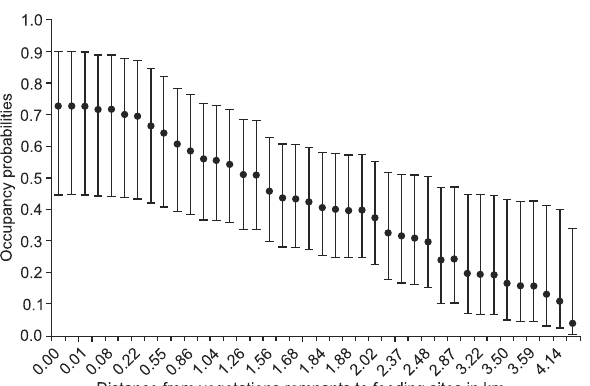
Figure 3. Estimate of occupancy probability of vegetation rem- nants as communal roosts of Black Vultures ( Coragyps atratus ) for each covariate, with error bars showing 95% confidence bounds.